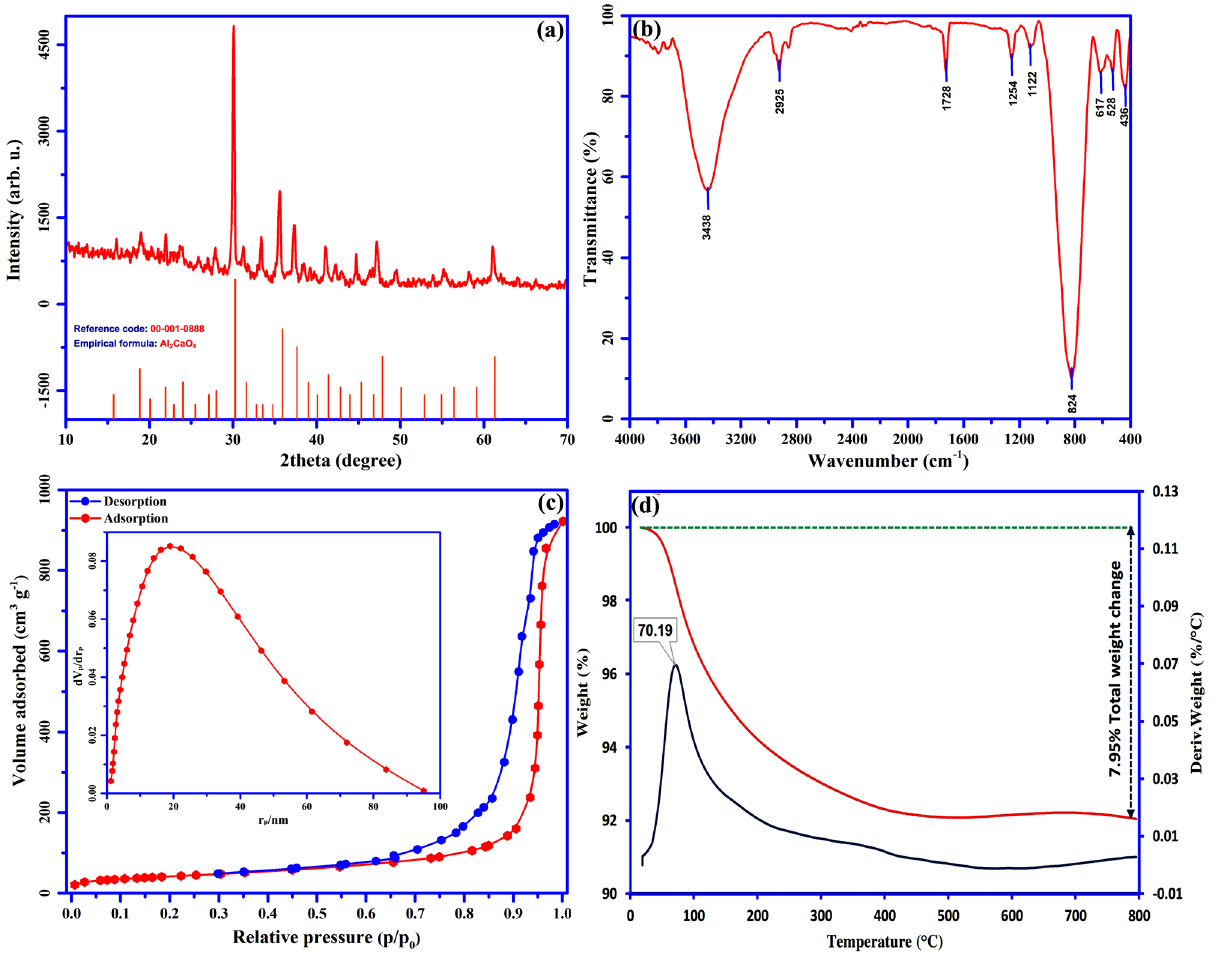
Figure 4. ( a ) X-ray diffraction, ( b ) FT-IR spectrum, ( c ) Nitrogen adsorption-desorption isotherm and BJH pore plot (inset), and ( d ) TG/DTG curves of meso-CaAl 2 O 4